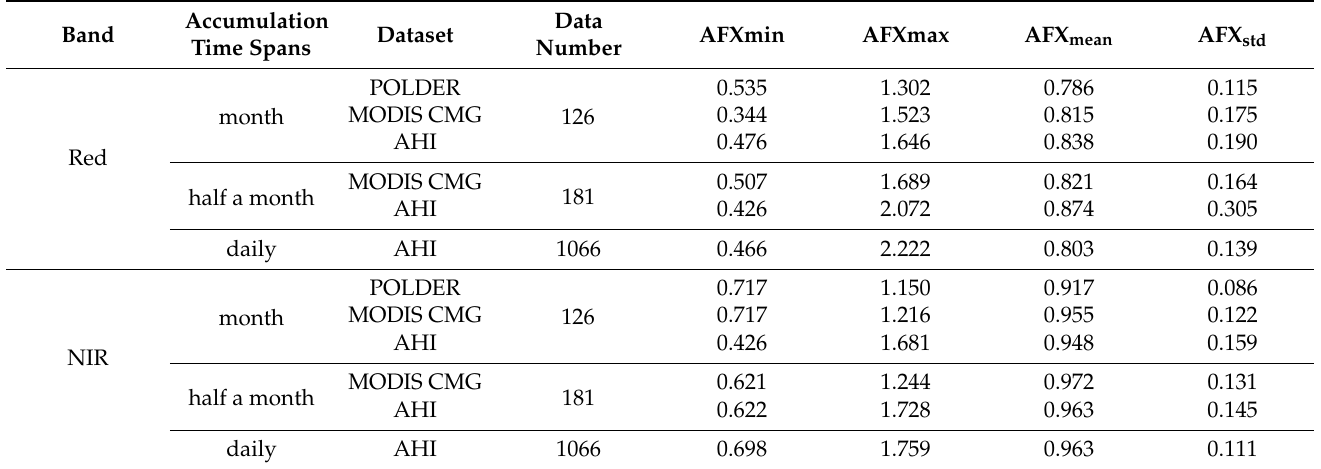
Table 7. AFXs retrieved from high-quality POLDER, MODIS CMG, and AHI multiangle data (number ≥ 7, WoD ≤ 2).